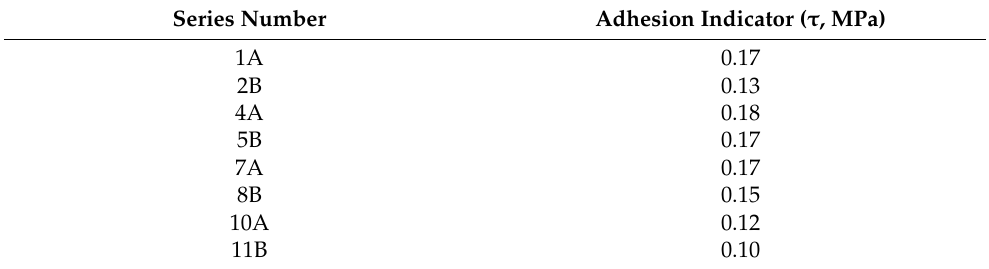
Table 6. Characteristics of adhesion of fibers to cement stone for monodispersion-reinforced specimens.